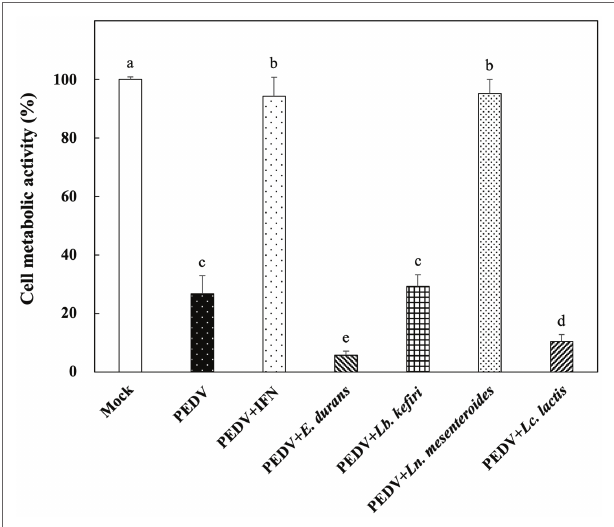
FIGURE 1 | In vitro prophylactic effects of the intracellular extracts of lactic acid bacteria isolated from kefir grains against porcine epidemic diarrhea virus (PEDV) infection in Vero cells. Bar chart showing percentage of cell metabolic activity of seven sample conditions: (1) Mock: cells pretreated with phosphate-buffered saline (PBS) and then mock-infected with PBS, (2) PEDV: cells pretreated with PBS and then infected with PEDV, (3) PEDV+IFN: cells pretreated with interferon (IFN)- α 2b and then infected with PEDV, (4) PEDV+ E. durans : cells pretreated with the intracellular extracts of Enterococcus durans and then infected with PEDV, (5) PEDV+ Lb. kefiri : cells pretreated with the intracellular extracts of Lactobacillus kefiri and then infected with PEDV, (6) PEDV+ Ln. mesenteroides : cells pretreated with the intracellular extracts of Leuconostoc mesenteroides and then infected with PEDV, and (7) PEDV+ Lc. lactis : cells pretreated with the intracellular extracts of Lactococcus lactis and then infected with PEDV. All data are expressed as mean ± SD ( n = 3). Bars marked with the same letter are not significantly different ( p >